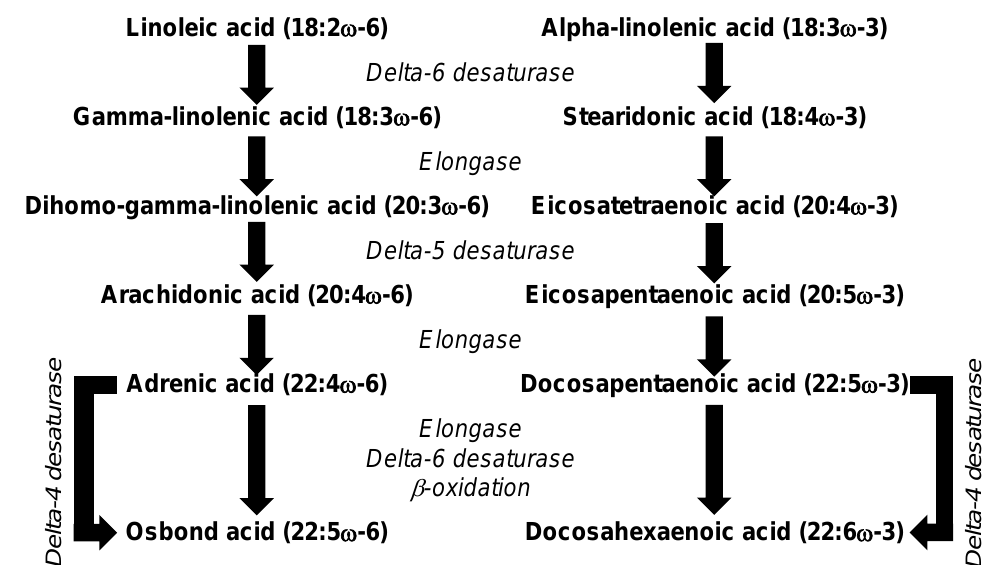
Figure 3. Pathway of conversion of essential fatty acids to their more unsaturated and longer chain